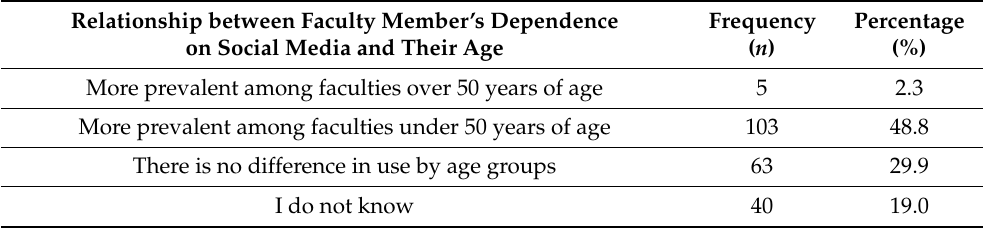
Table 5. Relationship between faculty’s dependence on social media for communication and their